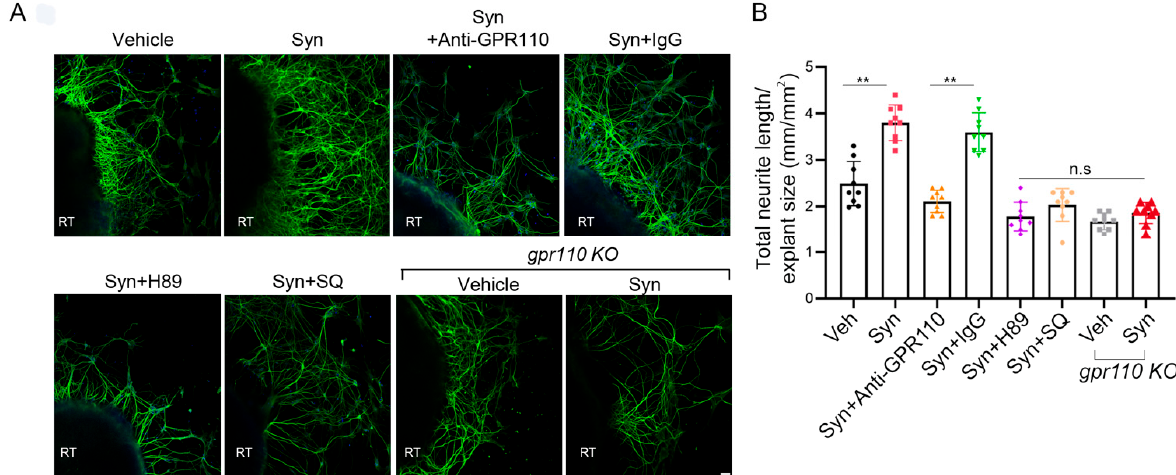
Figure 3. Retinal neurite outgrowth is stimulated by synaptamide through the GPR110/cAMP/PKA signaling pathway. ( A ), Neurite outgrowth from cultured P0 retinal explants increased by 10 nM synaptamide and inhibited by N-terminal targeting GPR110 antibody (0.4 mg/mL), SQ22536 (10 µ M), H89 (10 µ M), or gpr110 KO . The cultures were treated with agents on DIV 3 for 7 days and immunostained for β -III tubulin. ( B ), Total neurite length per field adjusted for the explant size. Data are expressed as mean ± s.e.m with n = 9 per group. ** p < 0.01 by one-way ANOVA. RT, retinal explant tissue. Scale bar, 50 µ m. n.s, statistically not significant.